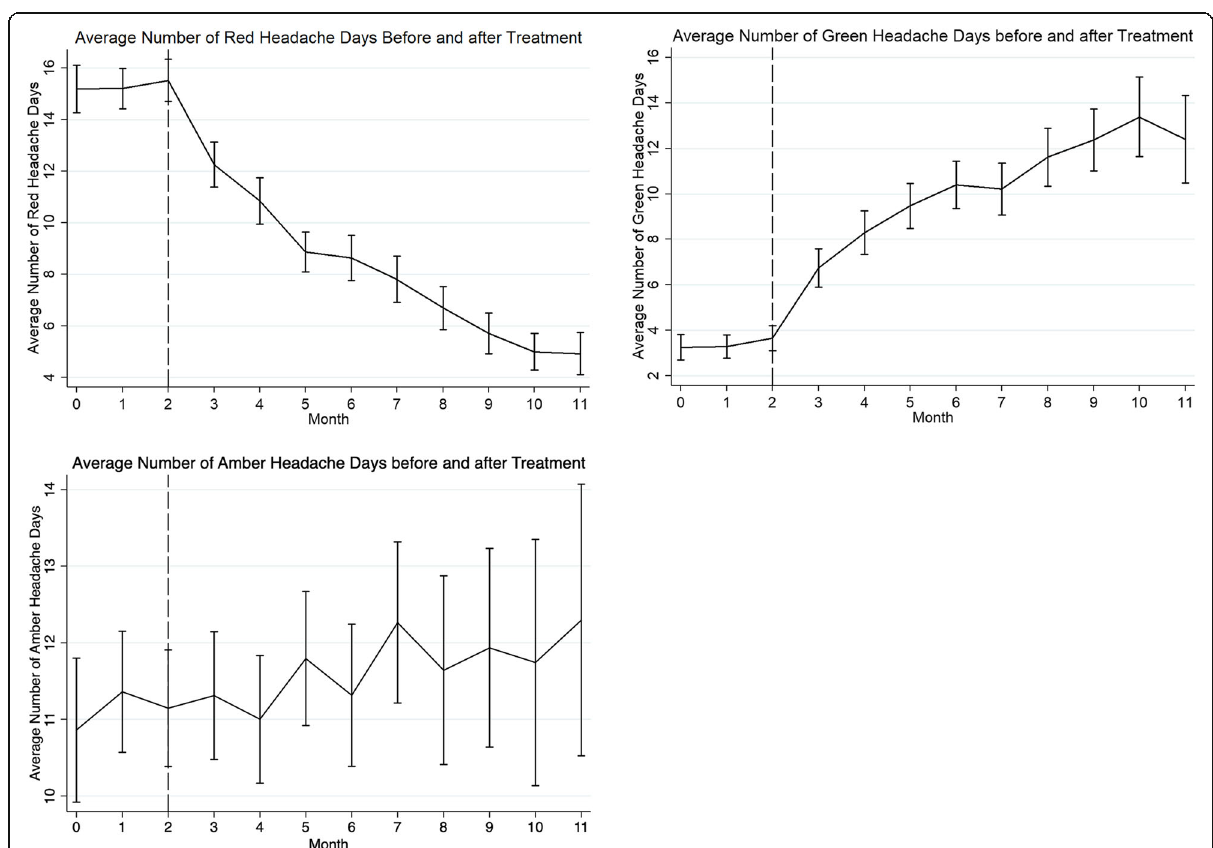
Fig. 3 Graphs showing change in mean monthly headache days before and after commencing erenumab. Three months of baseline data (month 0, 1, 2) is followed by 9 months of post-treatment data (month 3 – 11). Red days signify days with headaches that limit activities of daily